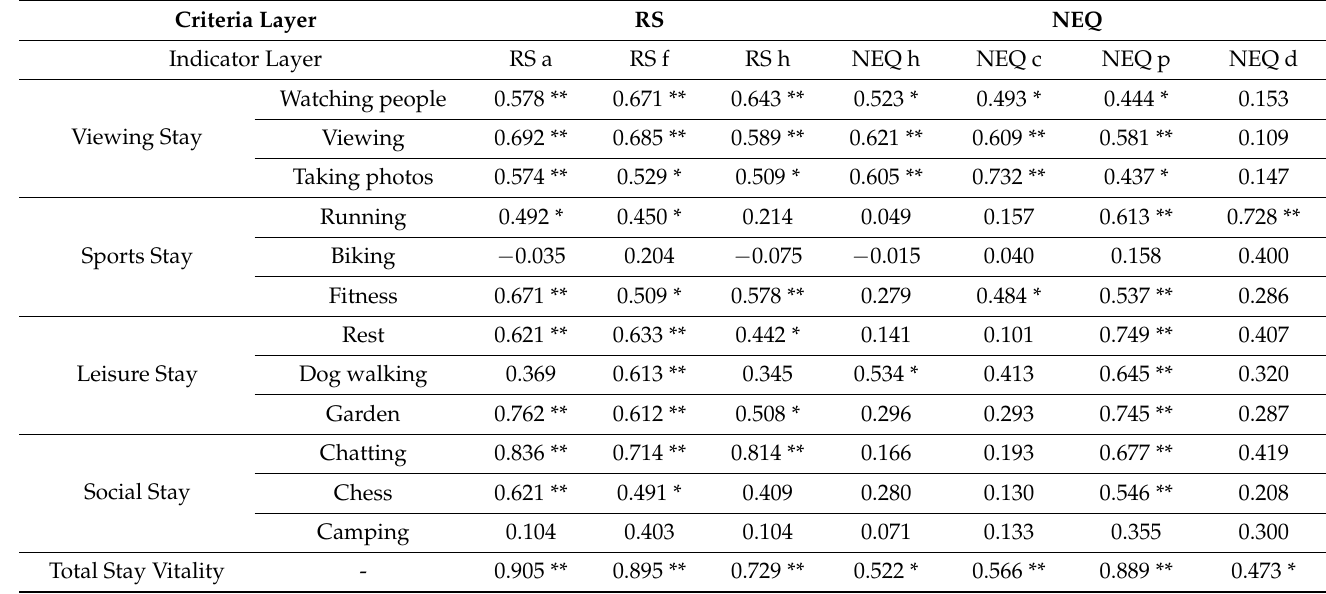
Table 6. Correlation analysis of waterfront spatial characteristics and total resident activities.